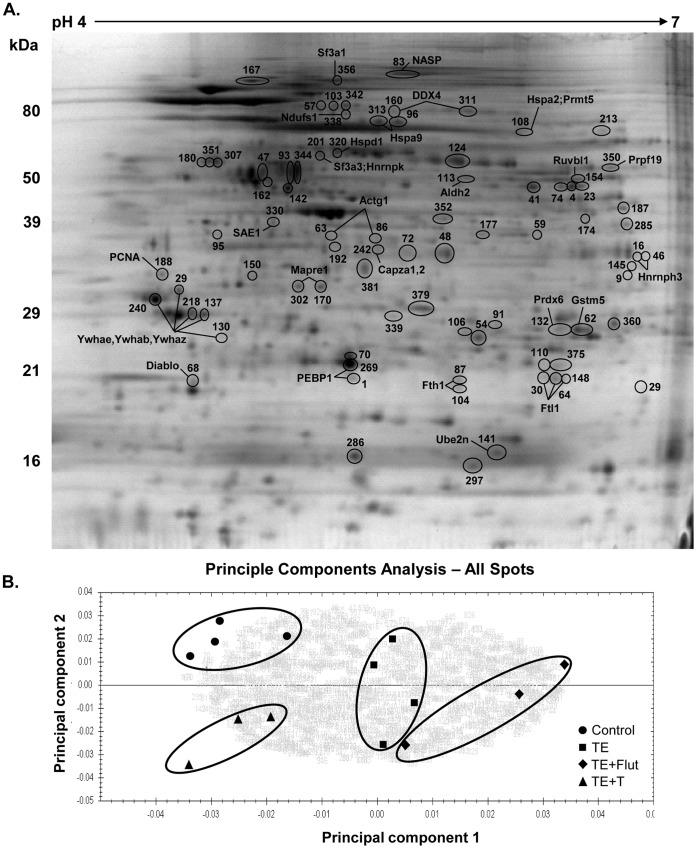
Proteomic analysis of enriched meiotic cell preparations.
A. Representative 2D-DIGE image of rat spermatocyte proteins (first dimension pH 4–7, second dimension 8–16% polyacrylamide gradient). The image shown is the Cy2-labelled internal standard which was added to all gels, and was prepared by mixing equal amounts of all samples (see Materials and Methods for details). Proteins shown to be significantly different (p<0.05) between groups by image analysis and subsequently identified by mass spectrometry are indicated (see Table 1 for details of spot identity). B. Principle component analysis of the expression patterns of all 738 spots identified four separate clusters corresponding to the four treatment groups.